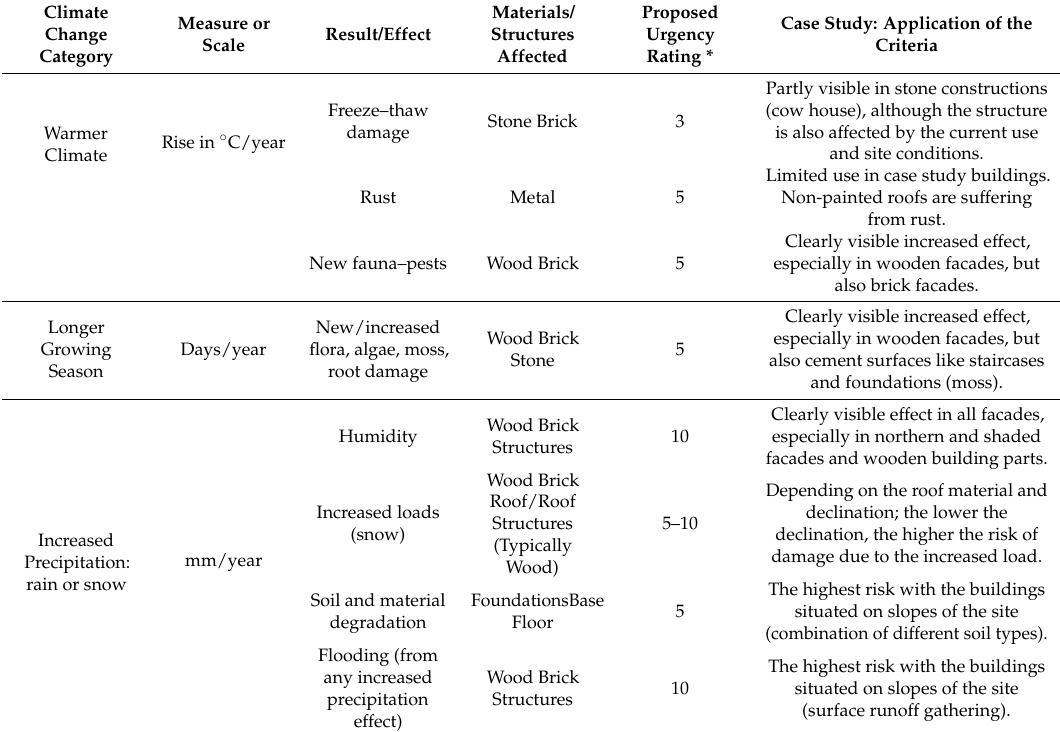
Table 1. Causes, results, and proposed level of urgency for acting, with comments on relevance to the case